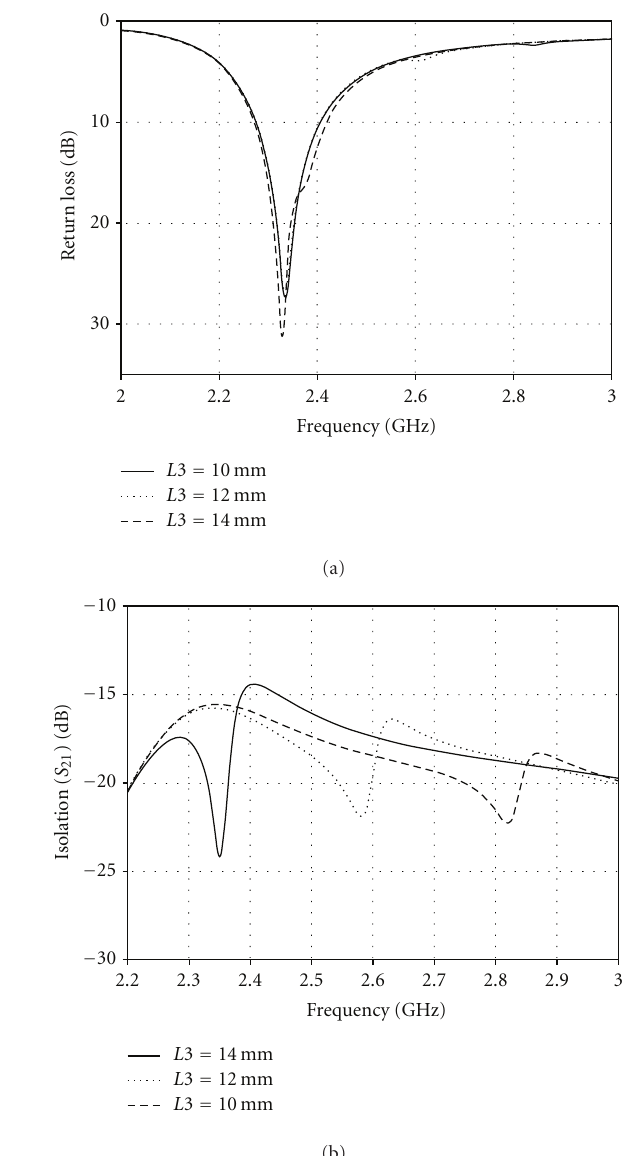
Figure 3: Simulated permeability of the interdigital SRR: (a) comparison between interdigital SRR and conventional SRR, (b) permeability for various L 3.